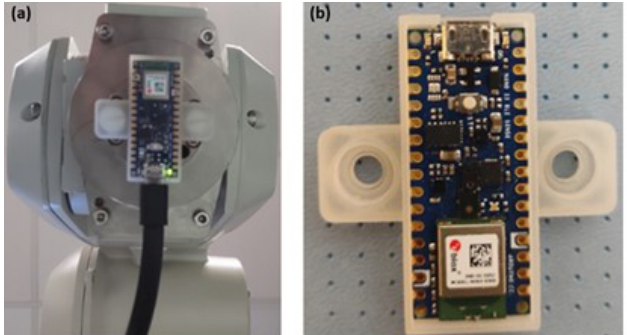
Figure 7. ( a ) Support for the Arduino board fixed to the end effector of the MELFA RV3-SB industrial robot by means of two M5 screws. ( b ) View of the support with an integrated board made with a 3D